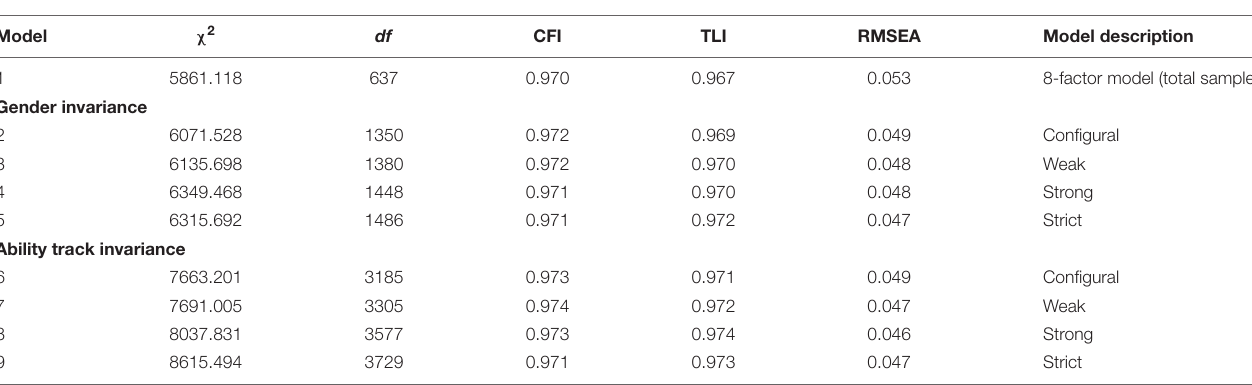
TABLE 2 | Goodness-of-fit indices of the